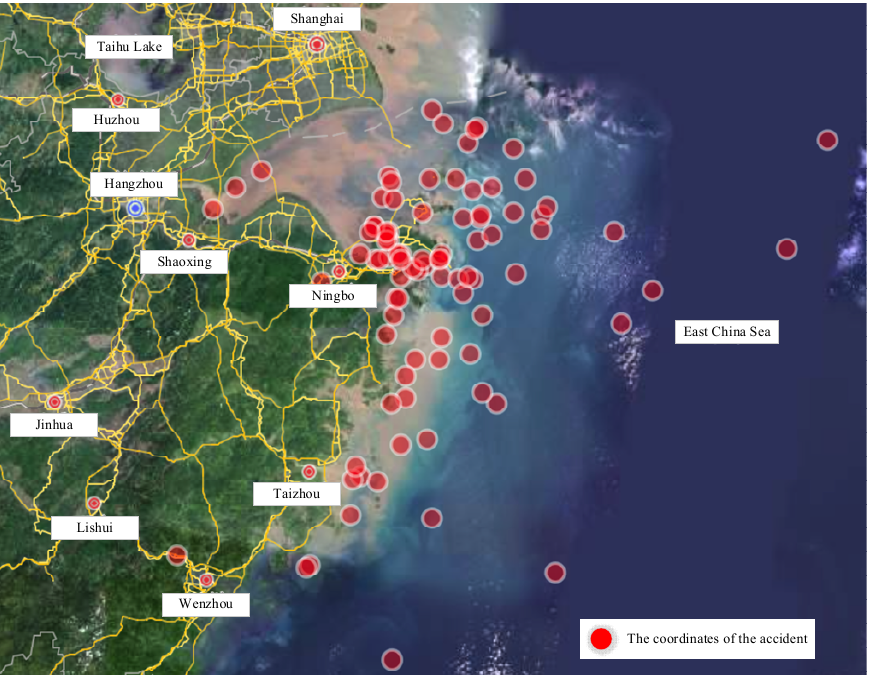
Figure 2. Map of maritime accident sites in Zhejiang, People ’ s Republic of China. Table 1. Features representation and classification of marine